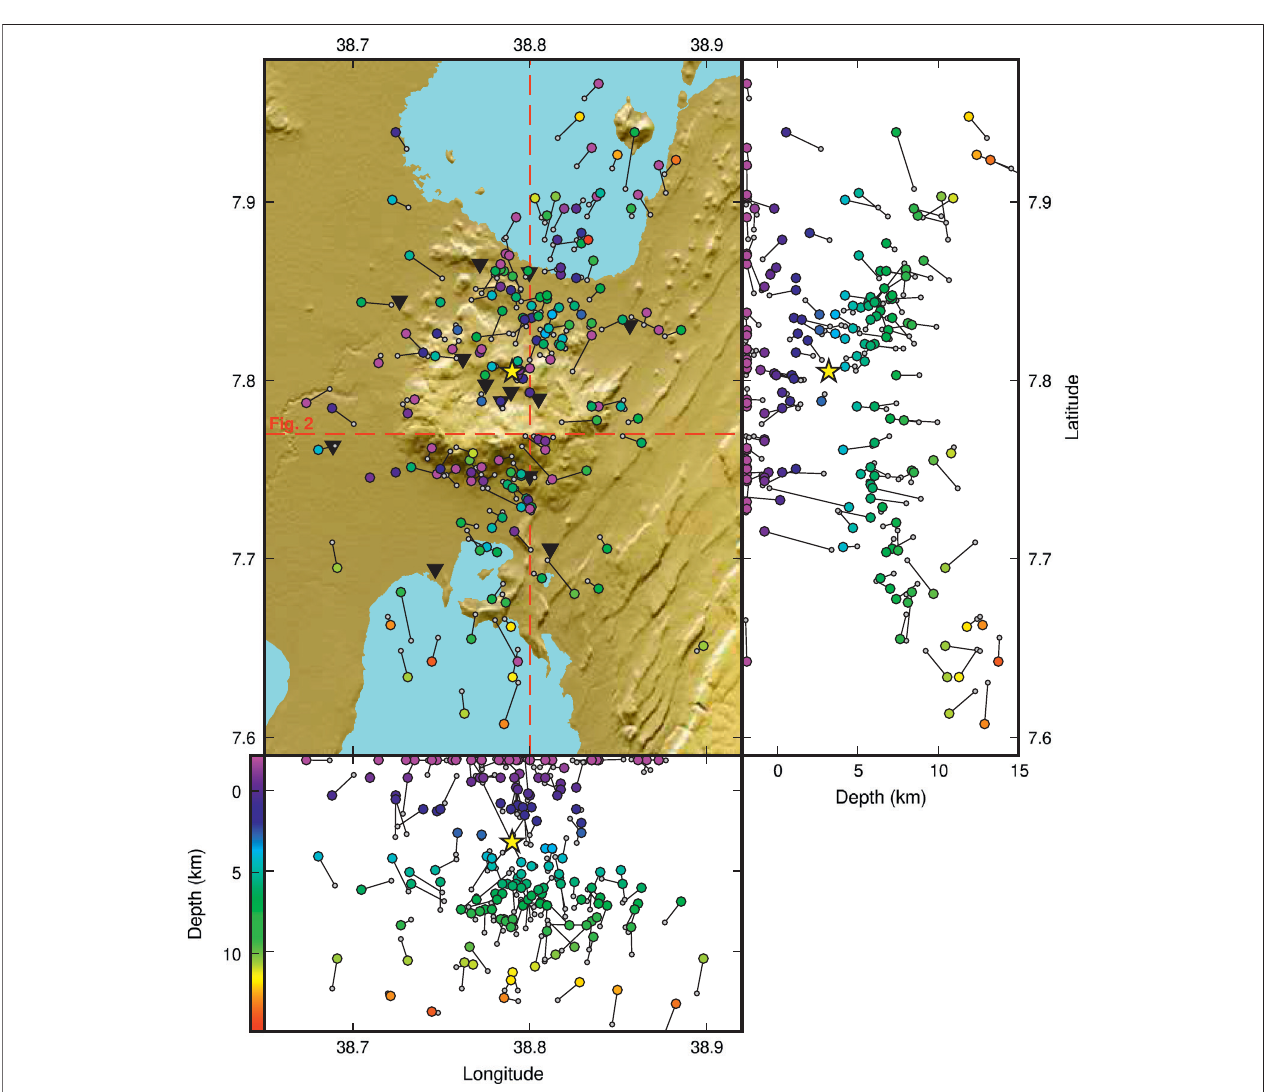
FIGURE 5 | Map of original and relocated hypocenters found by joint inversion for velocity structure and earthquake location. Small white circles show the starting location from Wilks et al. (2017), whilst larger circles show the fi nal relocations. Lines connect the original and relocated hypocenters. Color shows the depth of the relocations. Theyellowstarshows theinferred subsidence source foundbyHutchisonet al.(2016b).Red dashed lines indicate the locationofthenorth-south and east- west pro fi les shown in Figure 2 .